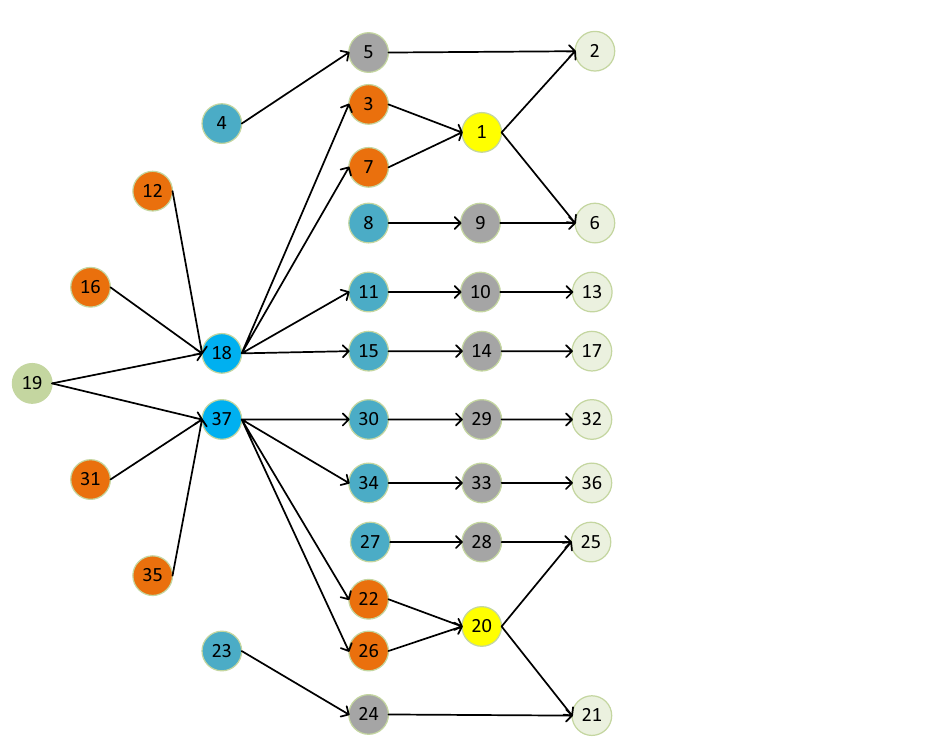
Figure 10. Double diaphragm coupling and the exploded view.